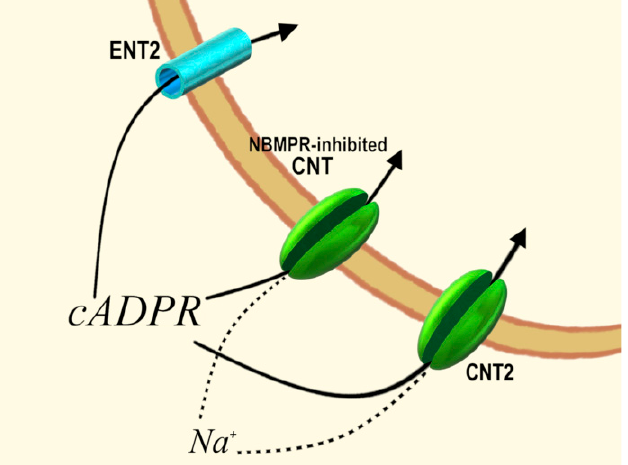
Figure 2. Uptake of extracellular cADPR through equilibrative and concentrative cADPR/nucleoside transporters. ENT2, equilibrative nucleoside transporter 2; CNT2, concentrative nucleoside transporter 2; NBMPR-inhibited CNT, nitrobenzoylthioinosine-inhibited concentrative nucleoside transporter.